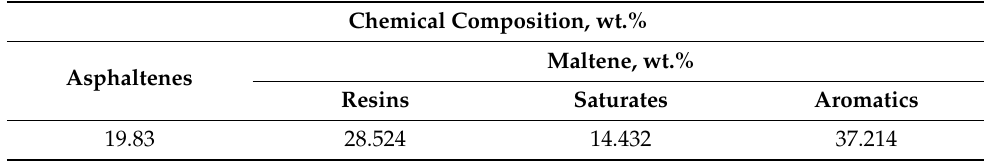
Table 1. Group composition (SARA) analysis of crude oil.